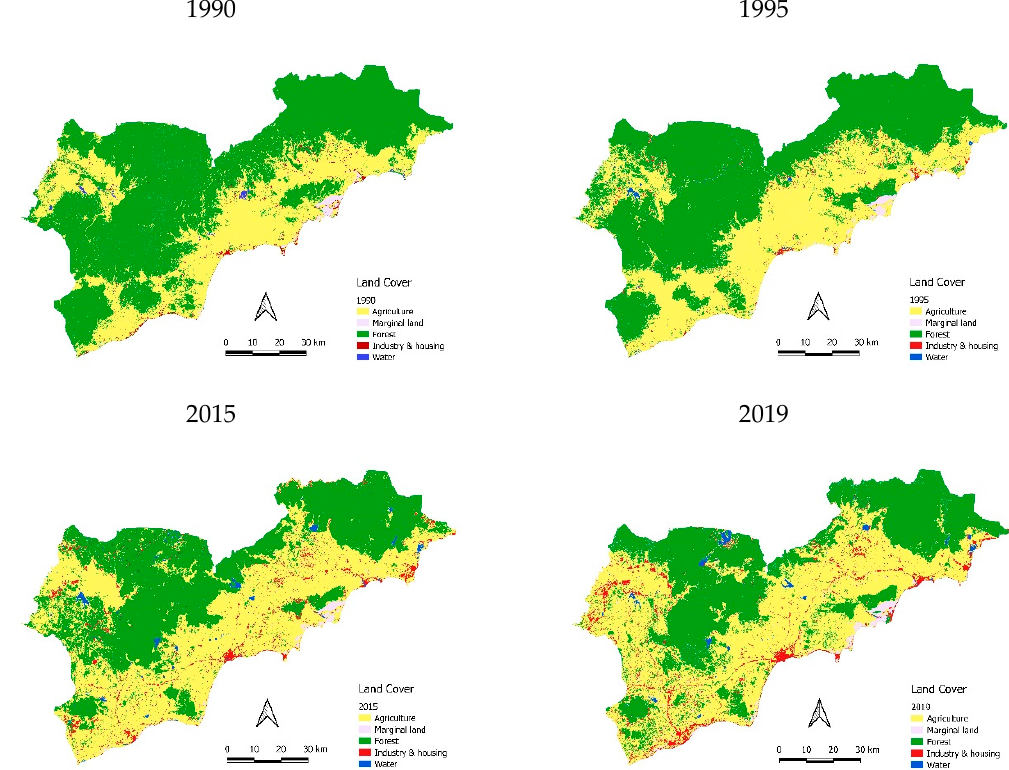
Figure A3. Land cover maps of the Binh Thuan province for selected years (1990–2019).